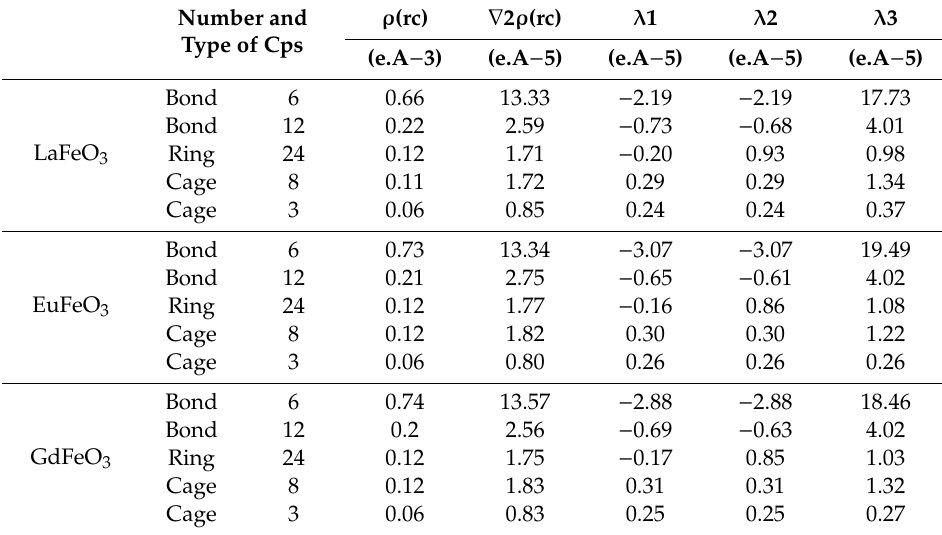
Table 5. Properties of electron density critical points of RFeO 3 (R = La, Eu,